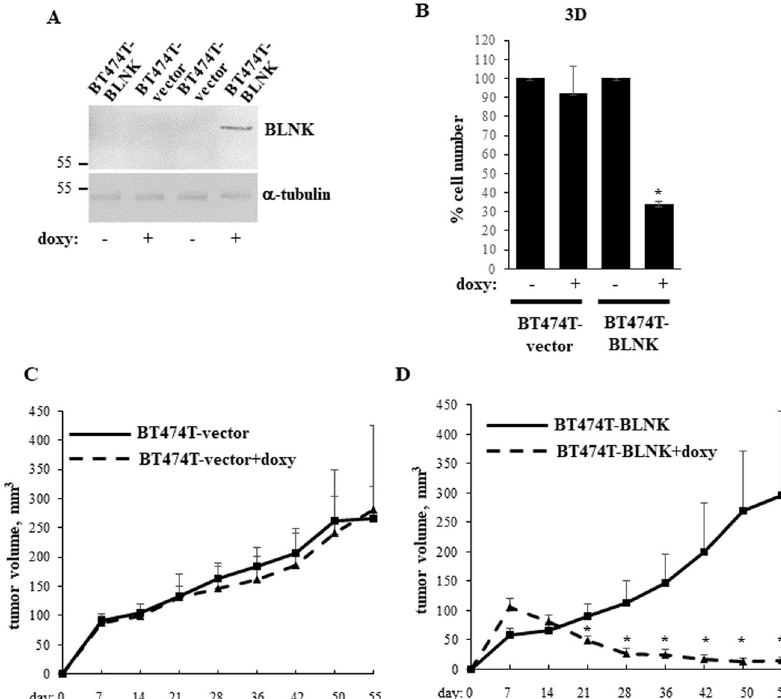
Fig. 8 BLNK blocks the ability of ErbB2-positive breast cancer cells to form tumors in mice. A Indicated cell lines were cultured detached from the ECM (3D) for 24 h in the absence ( − ) or in the presence ( + ) of 500 ng/ml doxycycline (doxy) and assayed for BLNK expression by western blotting. α -tubulin was used as a loading control. B Indicated cell lines were cultured as in A for 120 h in the ″ starvation ″ medium which represented the Hybri-Care medium supplemented with 0.1% Fetal Bovine Serum and diluted 2.5-fold with HBSS medium and counted. The data are the average of the three independent experiments plus the SD. * p -value < 0.05. C , D Female Nu/Nu Nude mice were injected with the indicated cells in the mammary fat pad ( n = 7). 2 mg/ml doxycycline was added or not to the animals ’ drinking water. Tumor volumes were measured at the indicated times. The data represent the average tumor volumes plus the SE. One mouse injected with BTLN3-BLNK cells was sacri fi ced on day 36 due to weight loss, one mouse injected with BTLN3-BLNK cells and receiving doxycycline was sacri fi ced on day 42 due to a tumor ulcer, one mouse injected with BTLN3-vector cells and receiving doxycycline was sacri fi ced on day 36 and another one, on day 55 due to diarrhea. upregulation blocks tumorigenicity of ErbB2-positive breast cancer cells in vivo. Increased BLNK breast tumor mRNA levels are associated with increased relapse-free survival of patients with ErbB2-positive breast cancer Since BLNK blocks breast cancer cell tumorigenicity (Fig. 8D), it is conceivable that increased BLNK gene expression in patients ’ tumors is associated with slower breast cancer progression. To test whether this is the case we used Kaplan – Meier plotter, a web- based platform that allows the analysis of the gene microarray expression data on breast cancer-derived mRNAs based on the Gene Expression Omnibus and European Genome-Phenome Archive repositories [34]. We found that in a cohort of 398 patients with ErbB2/Her2-positive breast carcinoma, increased BLNK mRNA expression is signi fi cantly associated with increased disease-free survival: p -value = 0.0018, hazard ratio = 0.6 (95% CI Fig. 9 High BLNK mRNA levels in patients ’ ErbB2-positive tumors 0.43 – 0.83) (Fig. 9). These data are consistent with our fi ndings that are associated with increased relapse-free survival. Kaplan – Meier BLNK blocks 3D breast cancer cell growth. analysis-based estimation of probabilities of patients ’ relapse-free In summary, we have discovered a novel mechanism of ErbB2- survival depending on the level of BLNK mRNA was performed. driven breast tumor growth driven by ErbB2-dependent BLNK Patients were split by ″ lower quartile ″ , ER status - array was ″ negative ″ , subtype PAM50 was ″ HER2 + ″ . downregulation. downregulation of the cell death-promoting protein BLNK [23, 35]. ErbB2-induced BLNK downregulation likely blocks the apoptotic form of death of detached cancer cells since we observed that ectopic BLNK triggers apoptosis symptoms in the cells, such as caspase-3 cleavage and Annexin V positivity (Fig. 5).